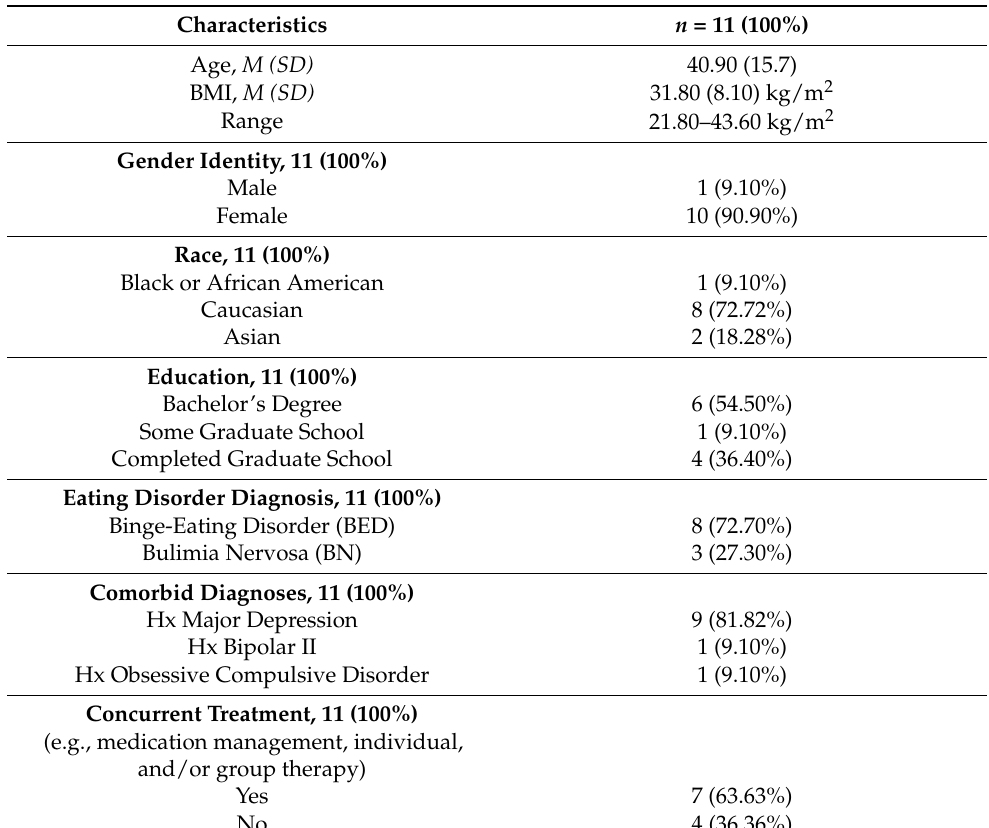
Table 1. Participant